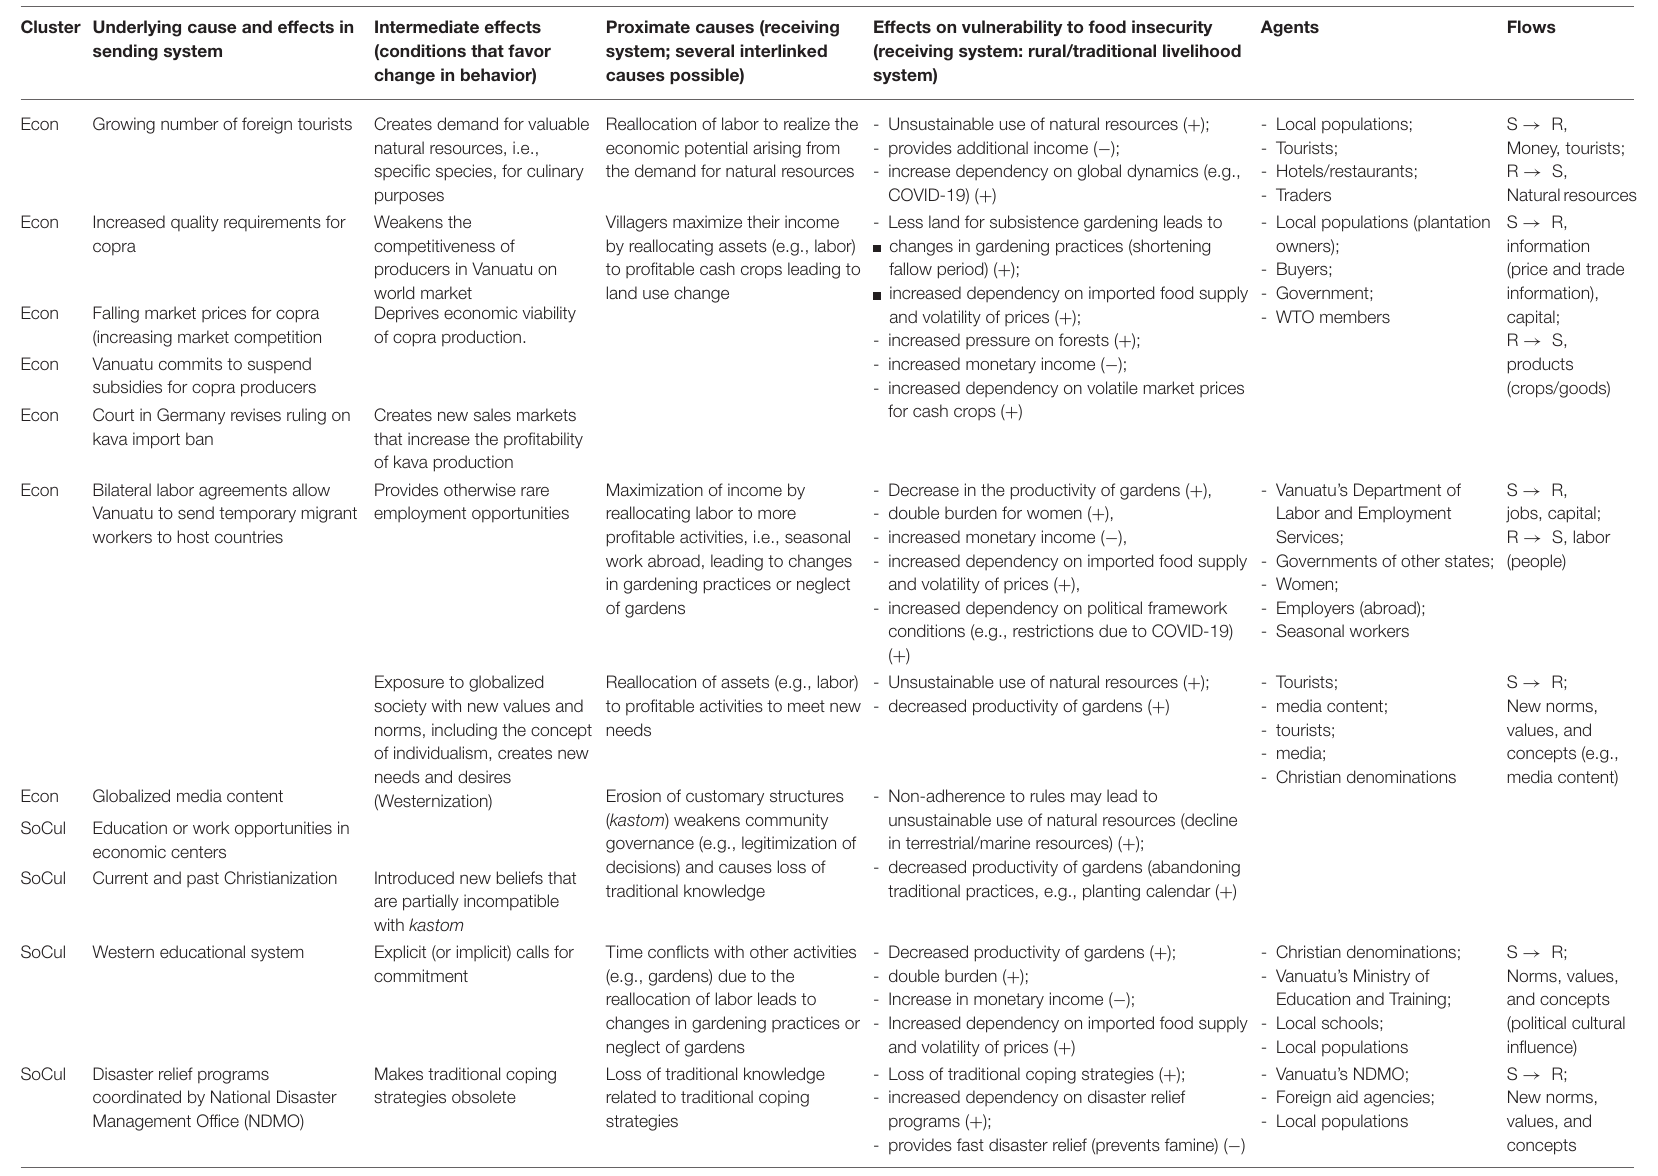
For all telecouplings, the table lists the most affected/involved actors and the identified flows. S → R describe a flow from the sending to the receiving system. R → S describes a flow from the receiving system to the sending system. The ( + ) sign indicates an increase and the (–) sign indicates a decrease in vulnerability to food